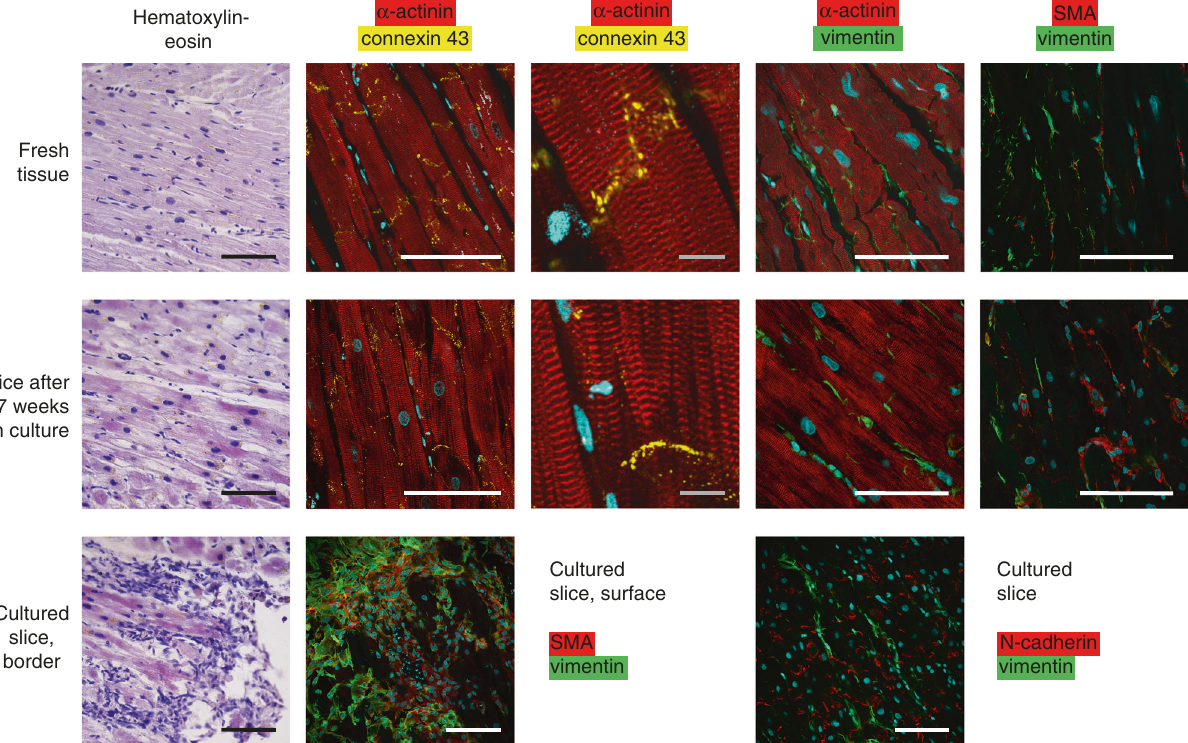
Fig. 4 Myocardial tissue structure after long-term cultivation. Fresh samples of failing myocardium (1st row) were compared with tissues cultured for fi ve or more weeks (2nd row). Staining of structural cardiomyocyte proteins ( α -actinin, connexin-43) and connective tissue markers (vimentin, α -smooth muscle actin (SMA)) are indicated in column headings. Accumulation of mesenchymal cells expressing either SMA or vimentin at the cut surfaces of cultured tissues and distinct localization of N-cadherin at intercalated discs are demonstrated in the 3rd row. DNA is depicted in blue. White and black bars represent 100 µ m, grey bars 10 µ m distances. Pictures exemplify three independent